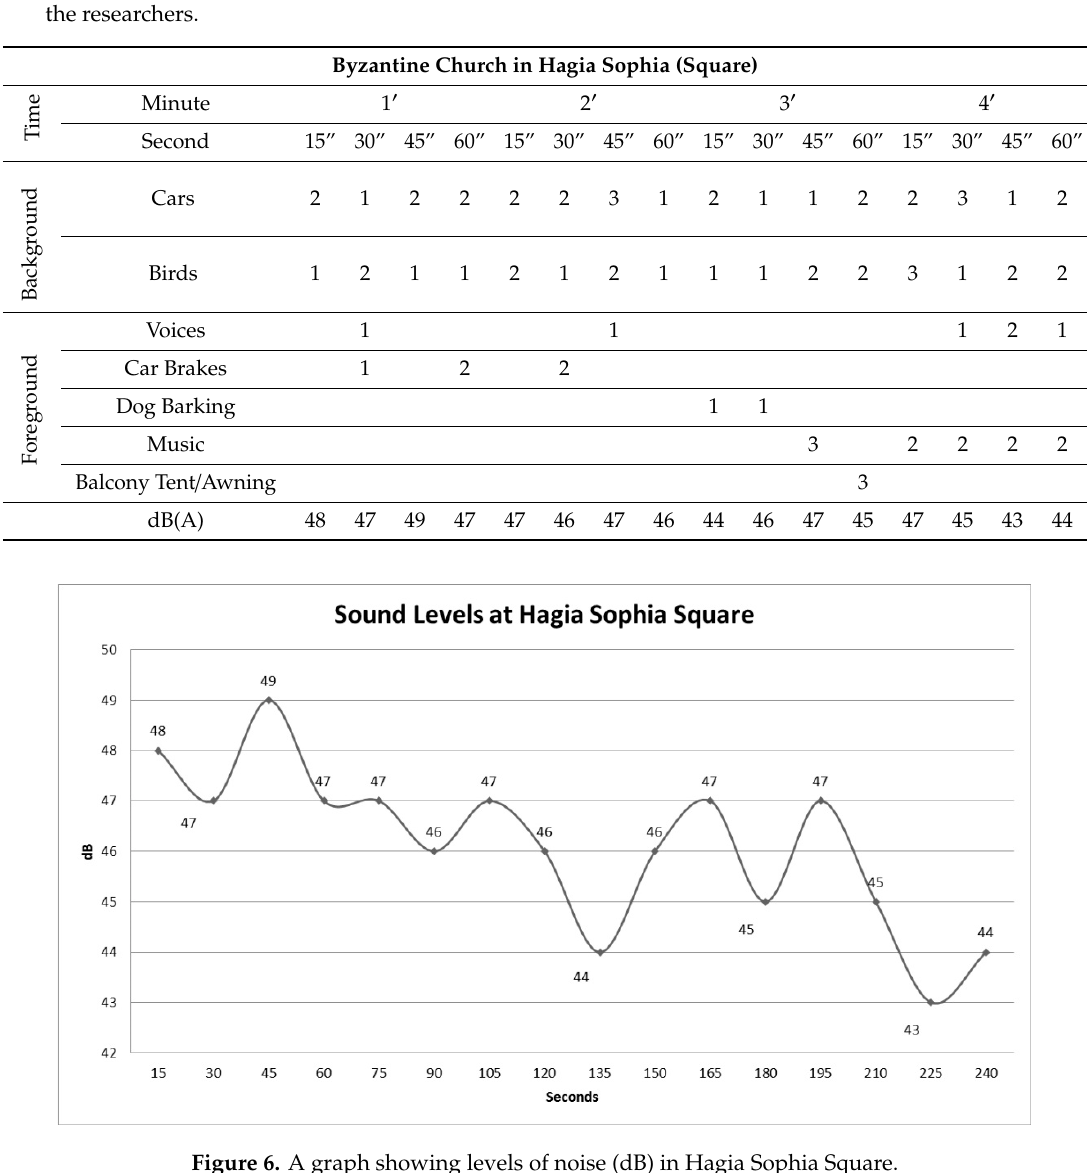
Figure 7. The spectrogram analysis of the Hagia Sophia Square sound recording. Despite the fact that low frequencies prevailed in the spectrum, an advanced complexity was noticeable in the high- frequency range. 3.2.3. Qualitative Data Sound Recording Identification One of the participants, after listening to the second audio sample, realized that the soundscape was of low intensity, pointing out that the sound recording took place at a building terrace in an apartment in the city center (Agia Sofia, Egnatia). While the other two participants pointed out that the city noise was heard from far away and attributed it to the fact that the sound recording probably took place in the middle of the COVID-19 quarantine. One of the participants was uncertain whether the sound recording took place on a high floor of a building, because the street sound sources were not loud enough.